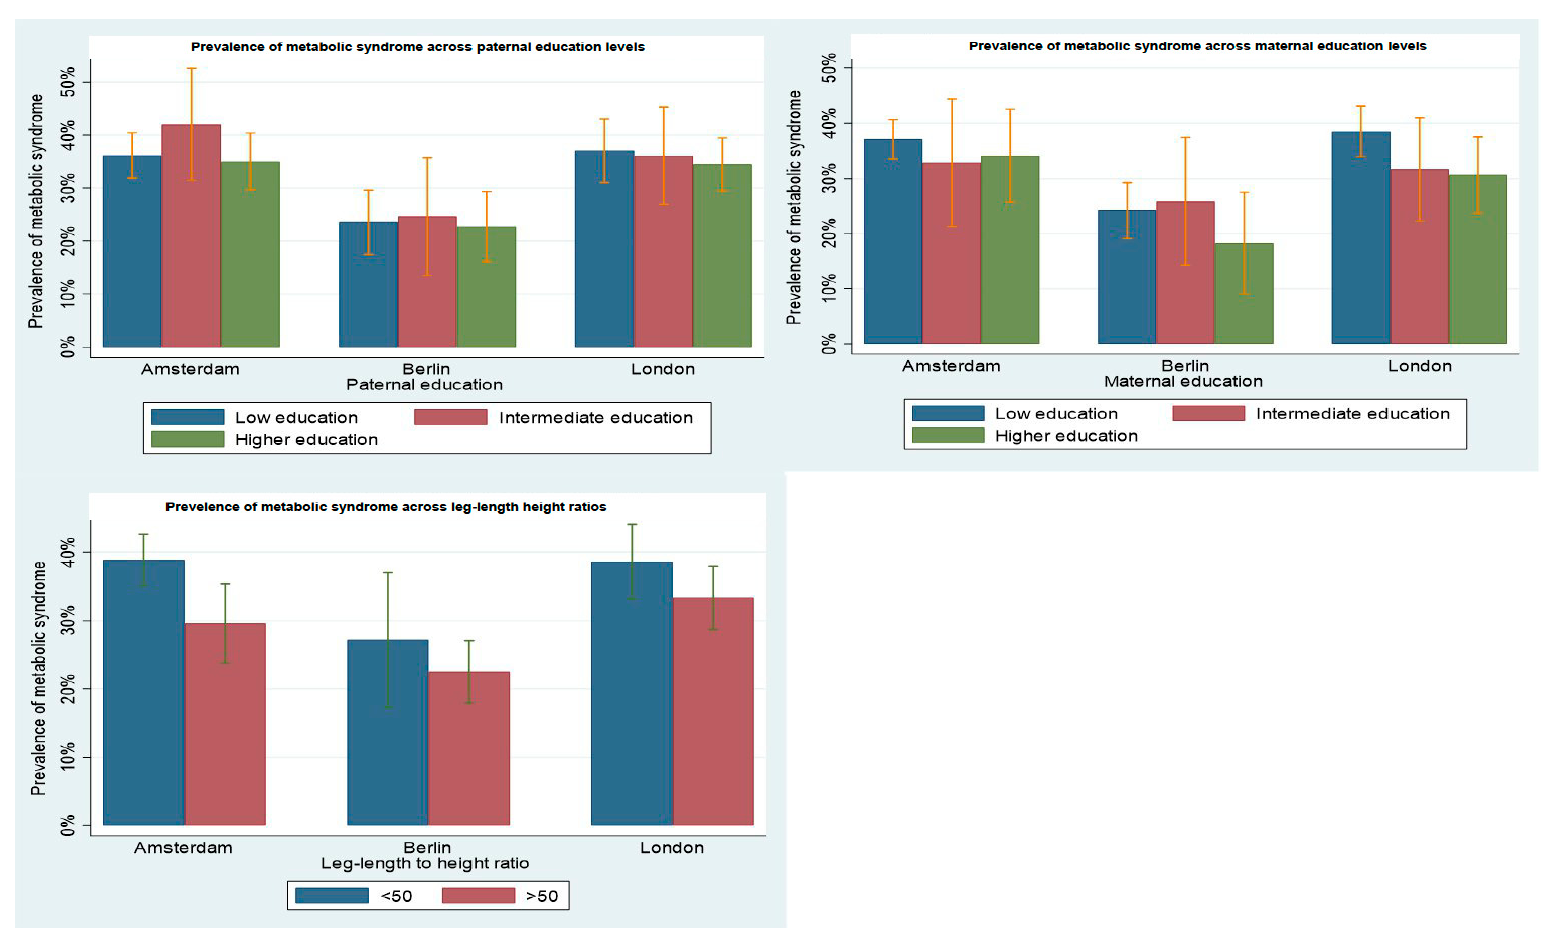
Figure A2. Prevalence of Metabolic Syndrome across Paternal Education, Maternal Education and Leg-Length to Height Ratios in Amsterdam, Berlin and London. Error Bars Are the 95% Confidence